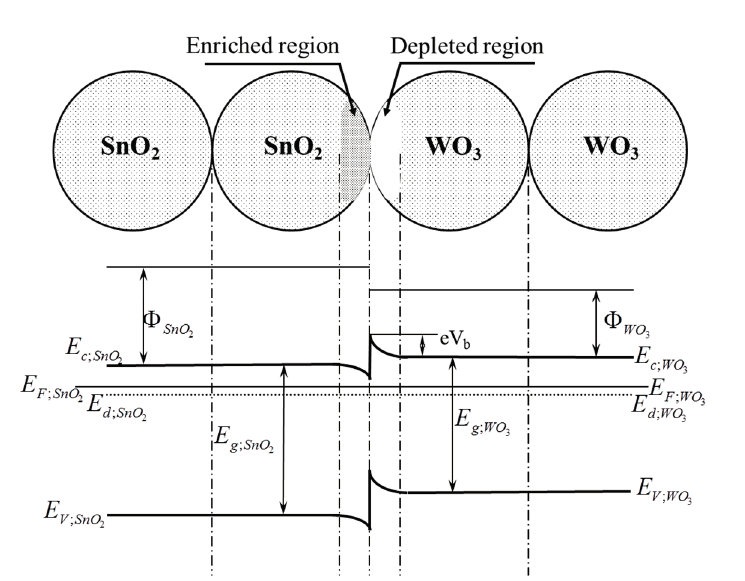
Figure 13. Schematic diagram of the contact of the grains of tin dioxide and tungsten trioxide as well as the band structure of these contacts in vacuum.